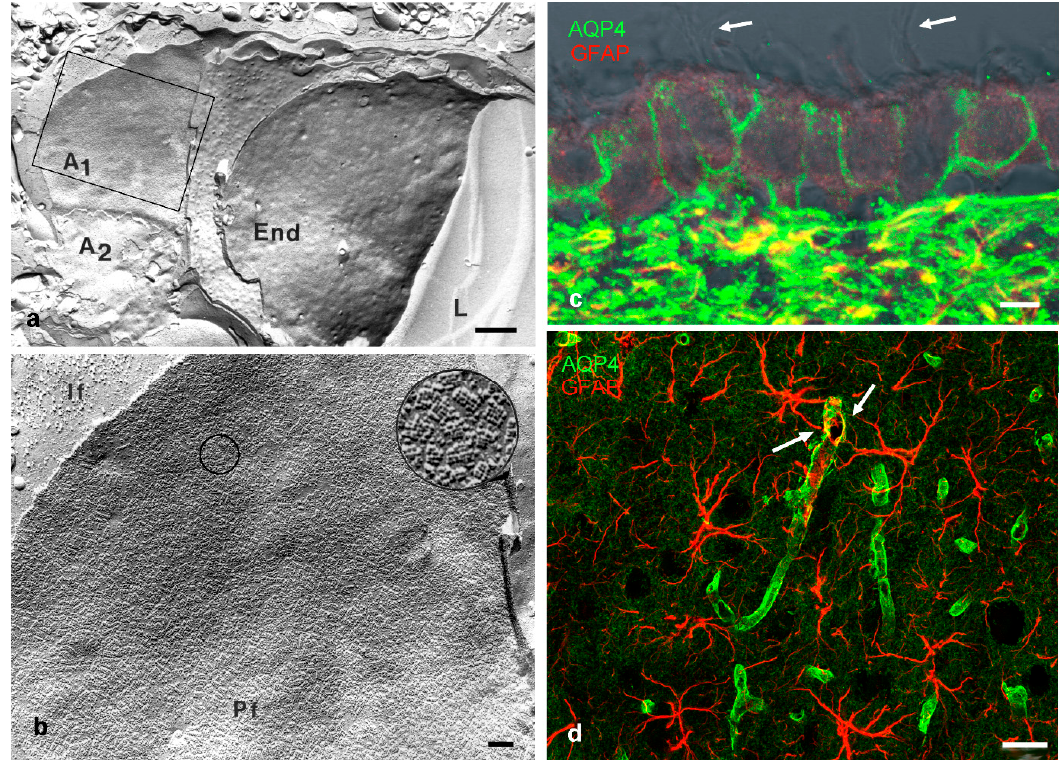
Figure 1. ( a ) Freeze fracture replica of rat brain tissue surrounding a capillary: the fracture plane goes through the lumen (L) of a capillary and the bordering endothelial cell (End). This is surrounded by astrocytes A1 and A2. The membrane of A1 indicated by the square is shown at higher magnification in b; ( b ) High densities of orthogonal arrays of particles (OAP) are found on astrocytic endfeet facing a basal lamina. The circled area is magnified further showing OAPs on the P-face (Pf) If: intermediate filaments; ( c ) Ependymal cells lining the ventricle; and ( d ), hippocampal astrocytes in rat brain stained for glial fibrillary acidic protein (GFAP, red ) and AQP4 ( green ). Ependymal cells are positive for AQP4 at their basolateral membranes, bearing cilia apically (arrows). Brain astrocytes in d show high AQP4 binding at their endfeet surrounding capillaries (arrows). Scale bars: ( a ) 1 µm; ( b ) 0.1 µm; ( c ) 5 µm; ( d ) 20 µm; ( a , b ) are modified from [24].